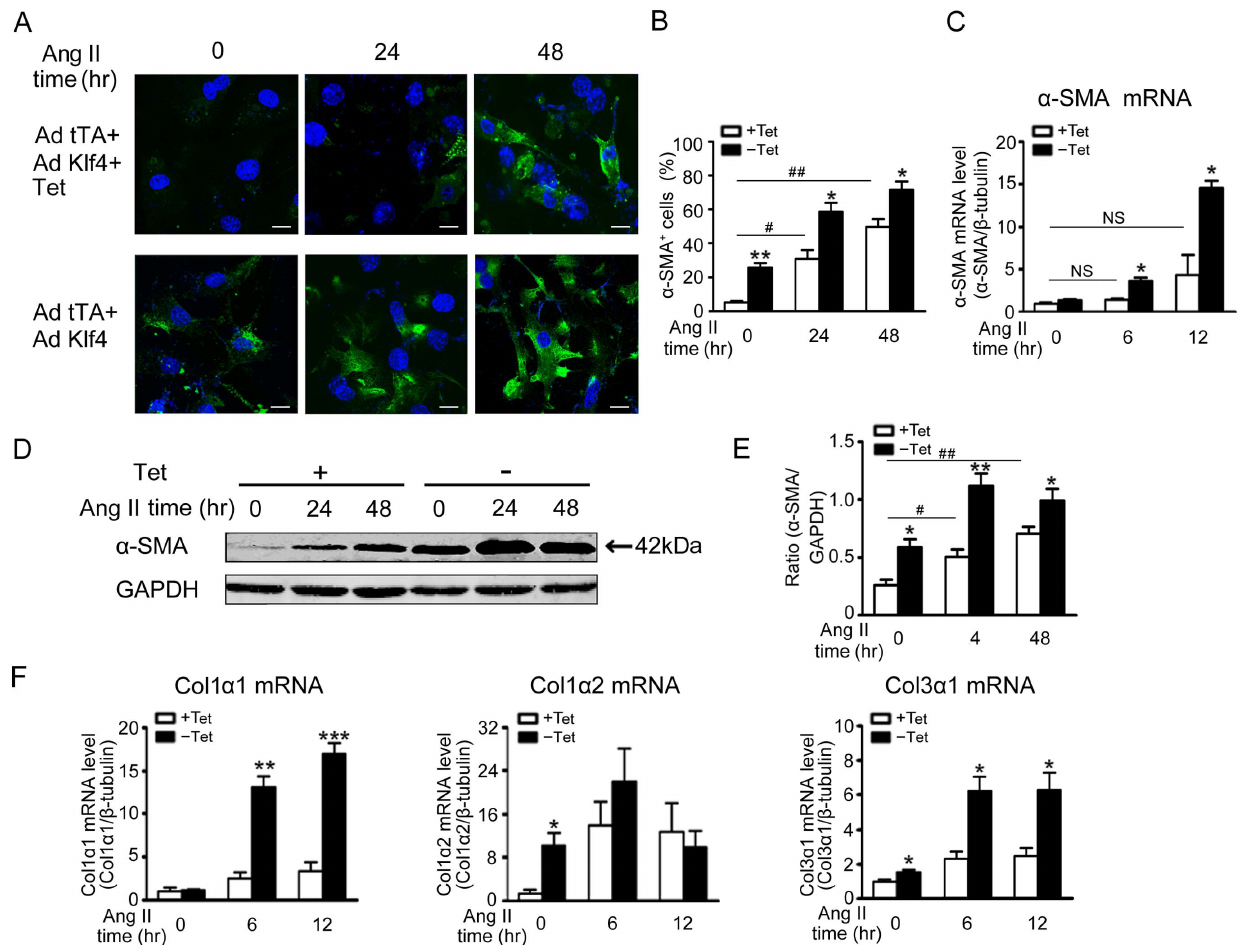
Figure 2. Elevated Klf4 promotes Ang II-induced fibroblast differentiation and collagen synthesis. Cardiac fibroblasts were exposed to co-infection of Ad-tTA and Ad-Klf4 for 2 hrs. After the viruses were washed off, infected cells were further incubated for the indicated time in the presence or absence of Tet (tetracycline, 0.1 m g/ml) for 24 hrs, then the cells were treated with Ang II (1 m mol/L). A, immunofluorescence analysis of myofibroblast differentiation by staining with a a -smooth muscle actin ( a -SMA) antibody after Ang II treatment for 0, 24 or 48 hrs. Scale bars: 10 m m. B, Quantitative analyses of a -SMA positive cells are presented (n=4). C, a -SMA mRNA levels were assessed by quantitative real-time PCR (qPCR) after Ang II treatment for 0, 6 or 12 hrs and normalized to b -tubulin (n=4). D, a -SMA protein levels were assessed by Western blot after Ang II treatment for 0, 24 or 48 hrs. GAPDH was a loading control. E, Level of quantification of a -SMA as a ratio of GAPDH in densitometric units was presented. n=4. F, Col1 a 1, Col1 a 2, Col3 a 1 mRNA levels were assessed by quantitative real-time PCR (qPCR) after Ang II treatment for 0, 6 or 12 hrs and normalized to b - tubulin. n=4. Data are the mean 6 SEM. *P , 0.05, **P , 0.01, ***P , 0.01 vs. control. # P , 0.05, ## P , 0.01 vs. control and Ang II treatment for 0 hr.